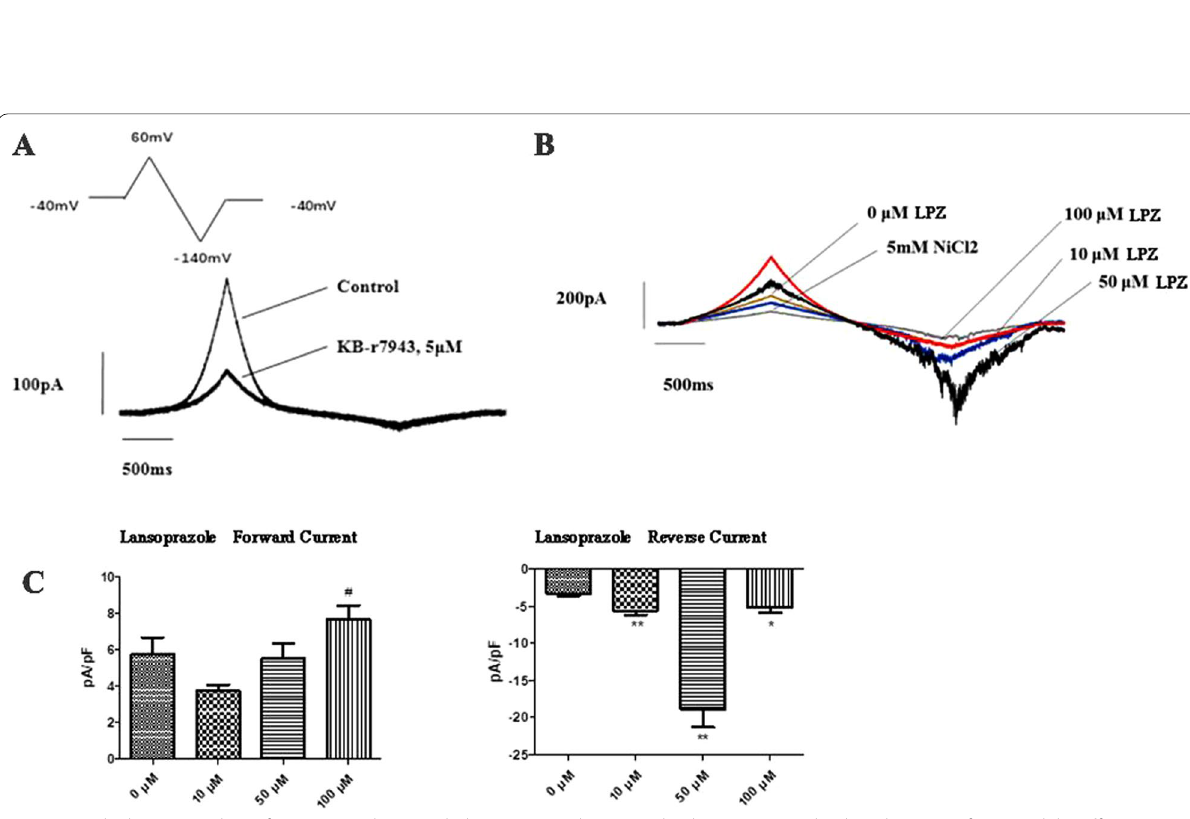
Fig. 9 Patch clamp recording of currents. A The recorded current was determined to be NCX. B Initial induced current of NCX and the effect of different lansoprazole concentrations and Ni 2 + on I NCX ; gray: 5 mM NiCl 2 ; brown: 0 µM lansoprazole; blue: 10 µM lansoprazole; black: 50 µM lansoprazole; red: 100 µM lansoprazole. C NCX current peak statistics of MC3T3-E1 cells in response to different lansoprazole concentrations; forward current density peak statistics, # P < 0.05 vs. the normal group; reverse current density peak statistics, * P < 0.05 vs. the normal group, ** P < 0.01 vs . normal group. (x s, n + =